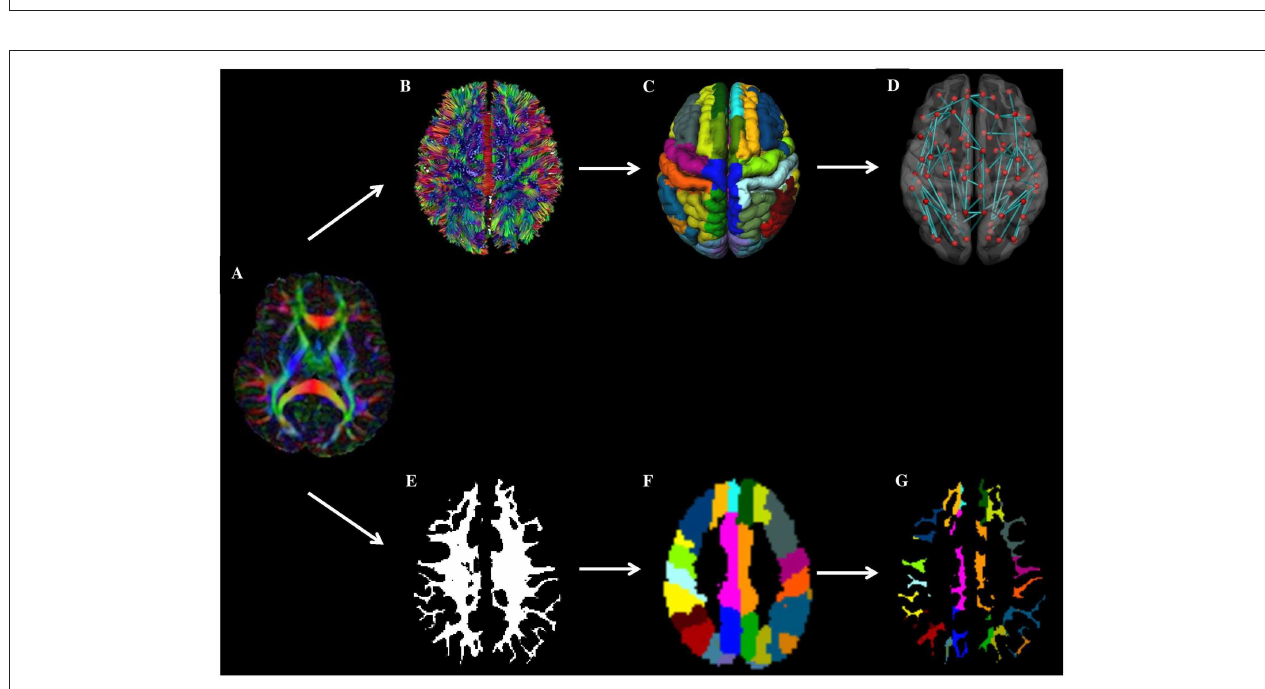
FIGURE 1 | 3D representation of the spatial distribution of cortical microinfarcts (CMIs; represented as black dots) across the brain in the cohort. The red areas represent the Automated Anatomical Labeling (AAL)-atlas regions with a high CMI burden (i.e., the 7 brain regions which contained 75% of all the cortical CMIs).